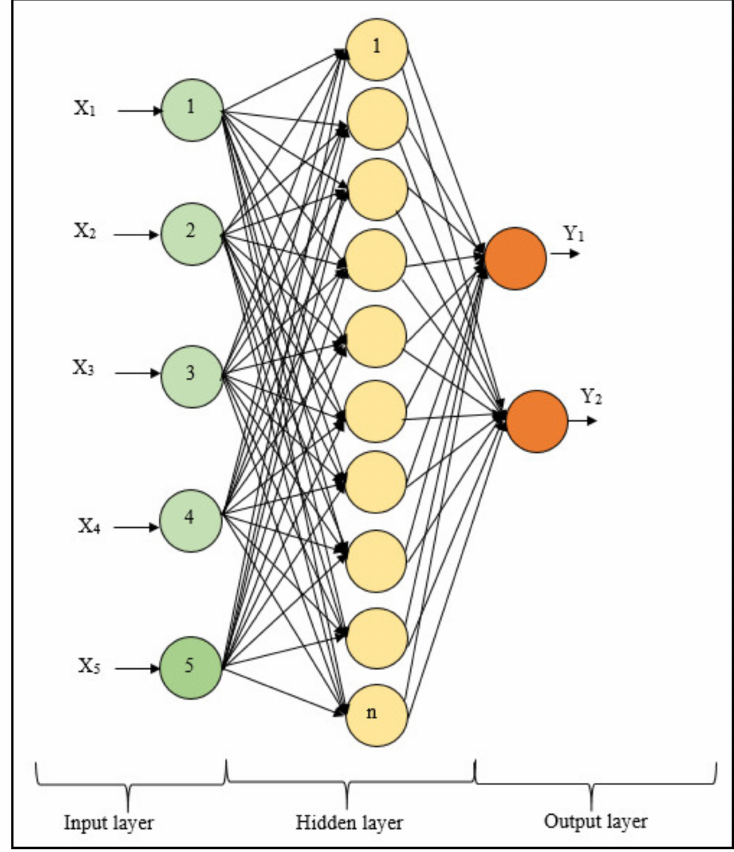
Figure 9. Architecture of neural